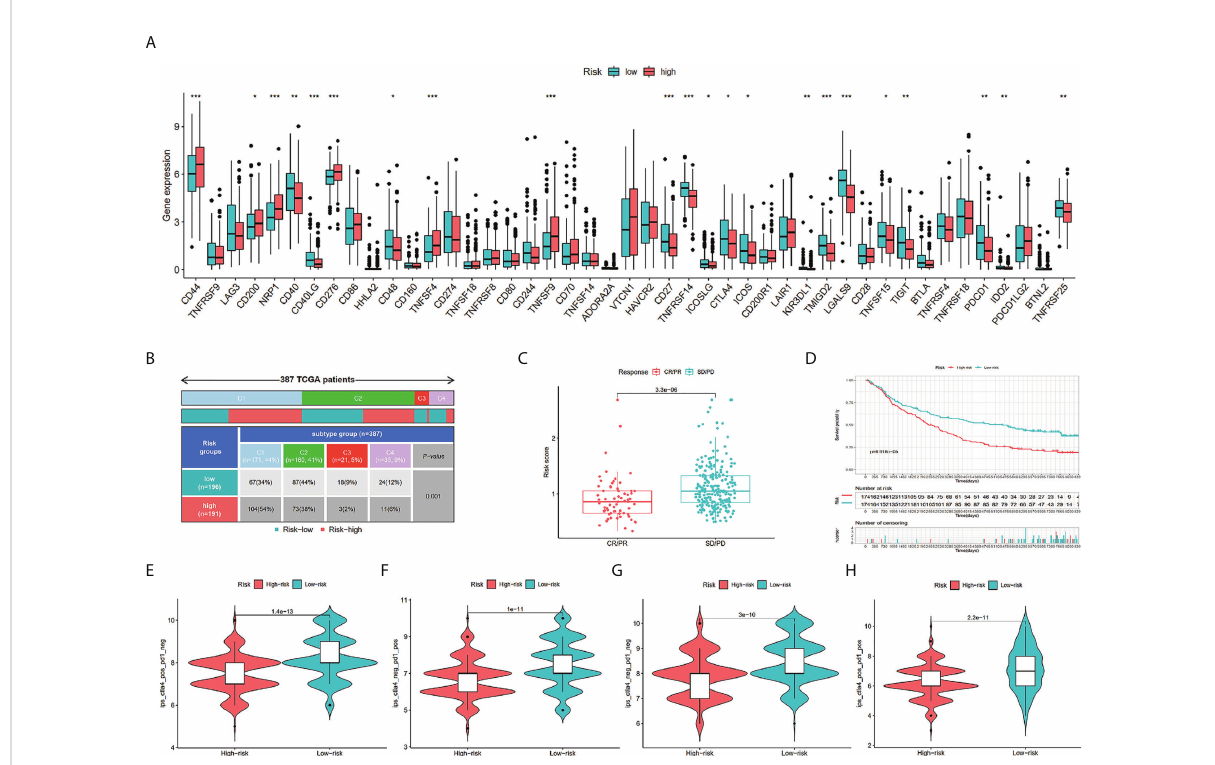
FIGURE 8 Comparison of the risk groups in our study with immune checkpoint genes and existing immune subtype and prediction of response to immunotherapeutic agents for different risk groups. The boxplot displaying the difference in immune checkpoint genes between different risk groups (A) . Comparison of the differences in immune subtype between different risk groups (B) . Comparison of risk scores between the CR/PR group and the SD/PD group (C) . The Kaplan-Meier curve survival analysis between the high- and low-risk groups in the IMvigor210 cohort (D)